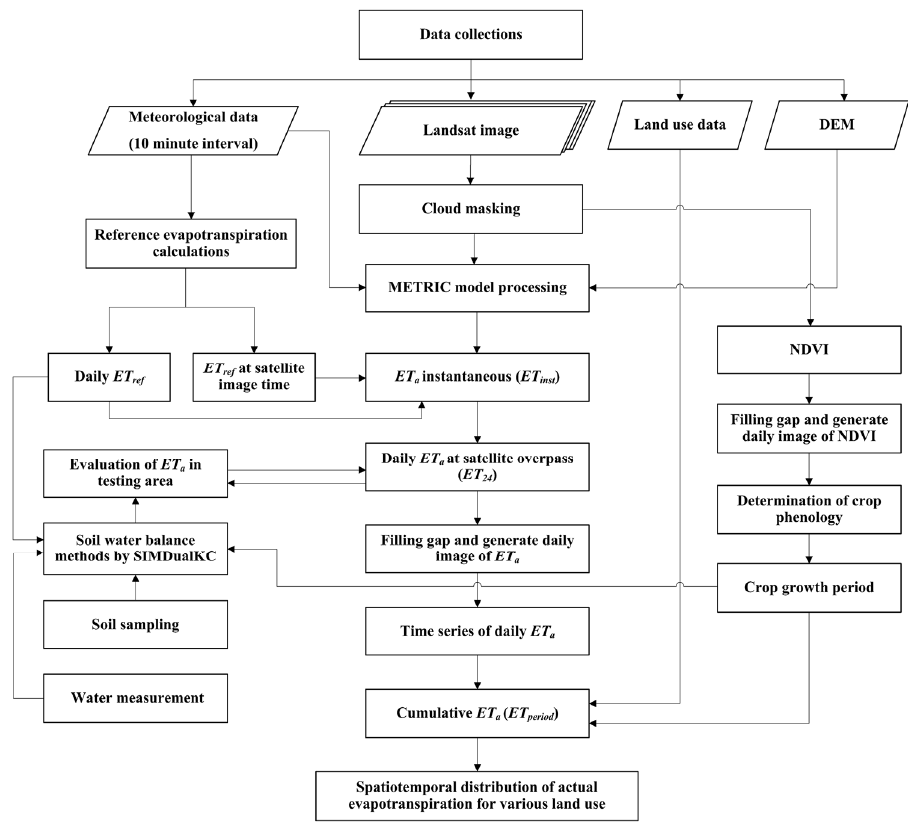
Figure 2. Frameworks and workflow for estimating actual evapotranspiration ( ET a ) during each crop growth period using the METRIC model and Landsat-8 satellite data; evaluating the ET a obtained from the METRIC model relative to the ET a calculated using the FAO-56 dual-crop coefficient method; and studying the spatiotemporal distribution of the ET a for various land-use types to improve water resource management in northern Thailand.